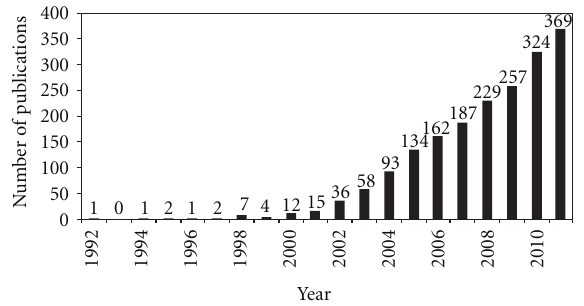
Figure 1: Published articles from 1992 to 2011. The information was retrieved from PubMed indexed articles using the exact terminology “stem cell